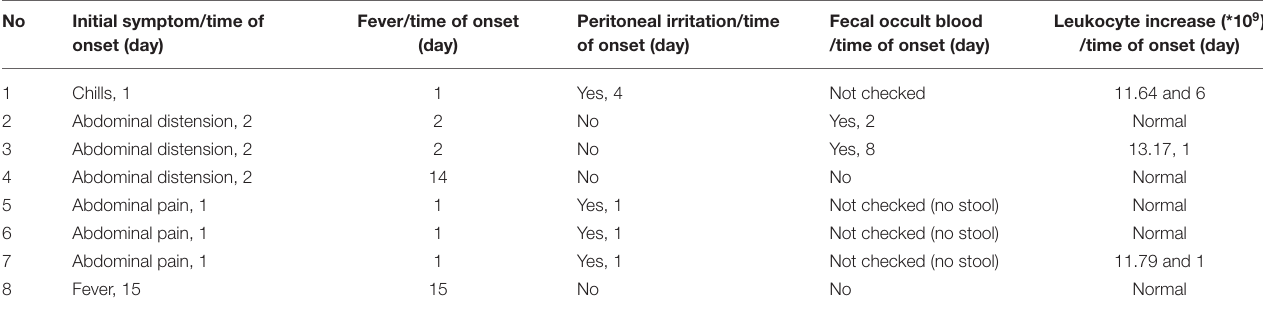
TABLE 3 | Symptoms associated with intestinal